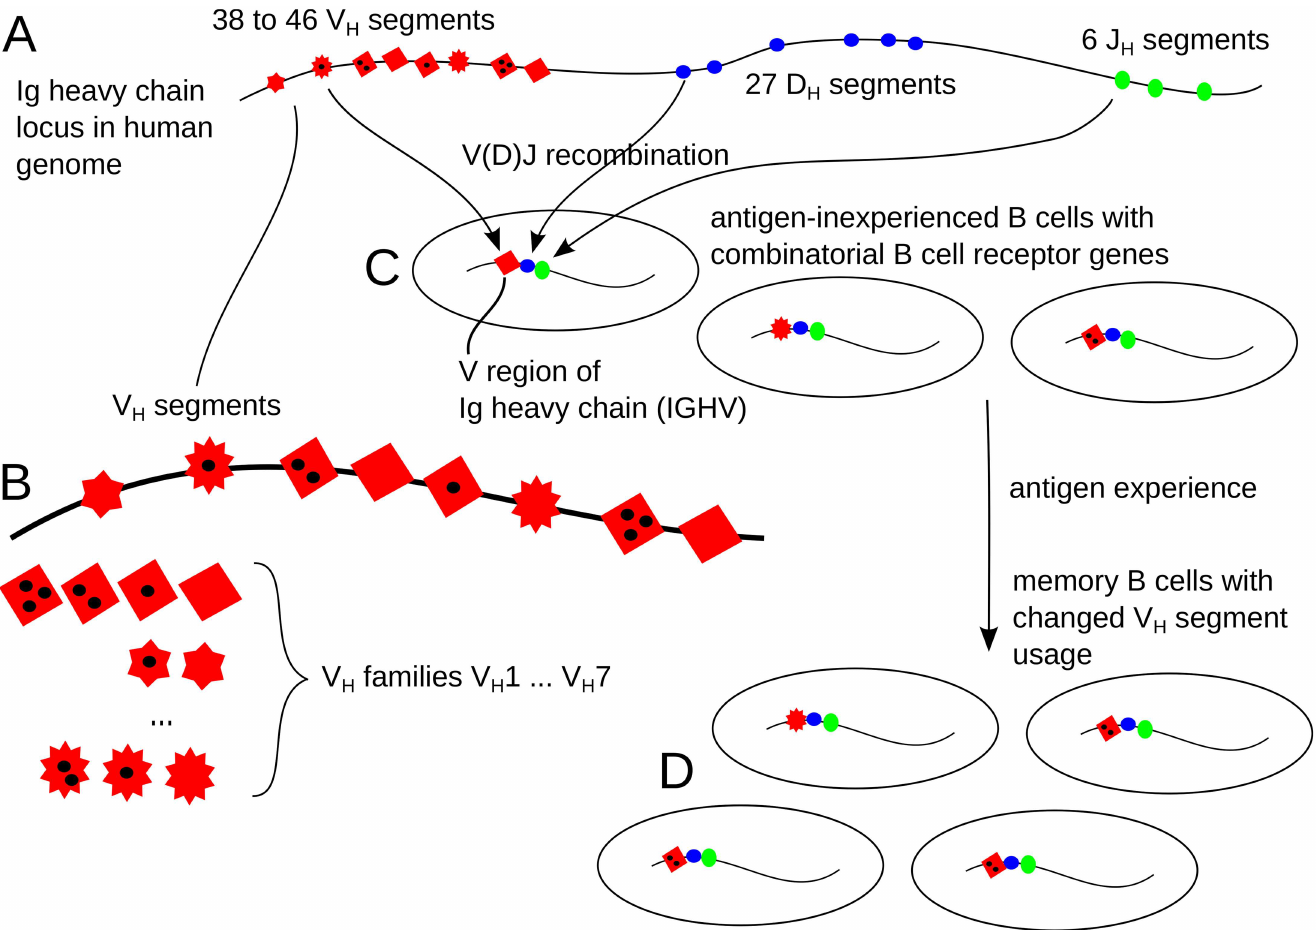
Fig 2. Diversity of the V H region of BCRs. (A) The humangenomecontainssets of V H , D H , and J H gene segments. (B) The “variable” V H segmentscan be groupedinto seven V H families based on sequencesimilarity. (C) A geneticallydiversepool of B cells is generatedby V(D)J recombination. (D) Exposureto antigensinducesan adaptationof the BCR repertoire, generating genetic variants and changing the usage pattern of V H gene